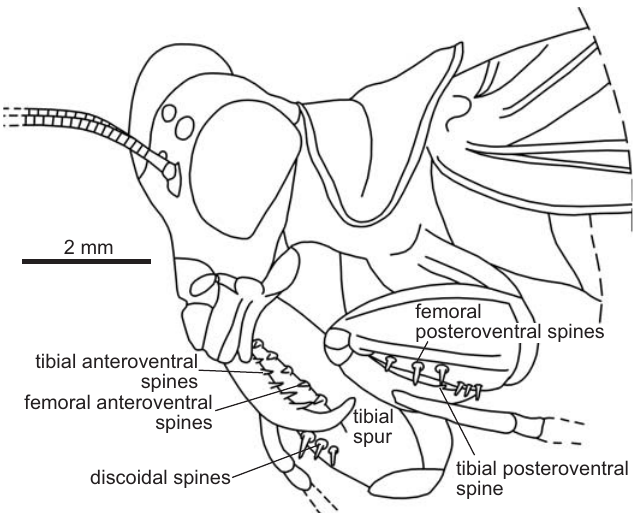
Fig. 6. Reconstruction of mantoidid mantis Pseudo man toida extendidera gen. et sp. nov., holotype